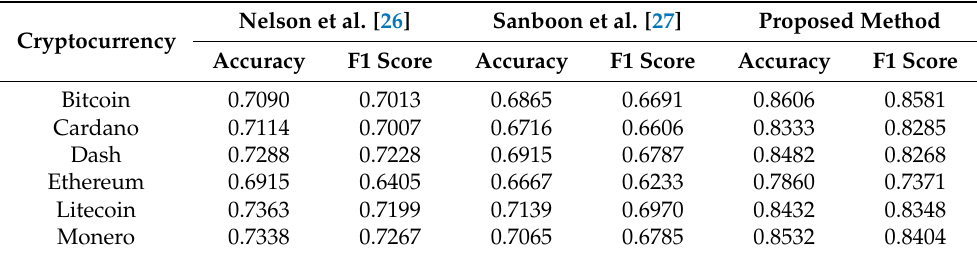
Table 6. Value of accuracy and F1 score for each cryptocurrency. Nelson et al. [26] Sanboon et al. [27] Proposed Method Cryptocurrency